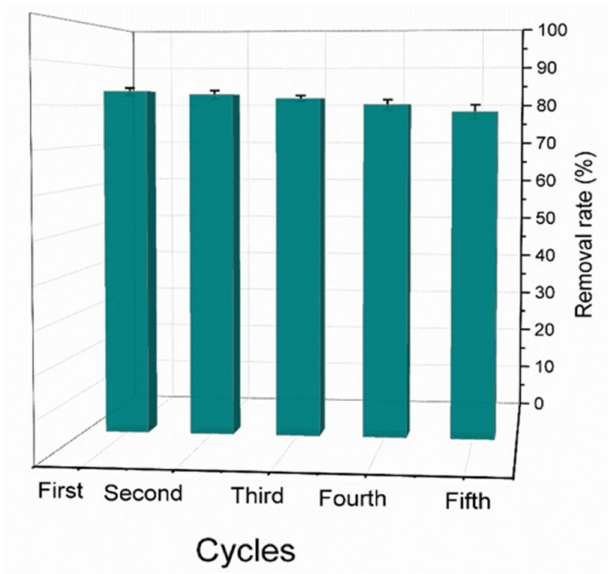
Figure 7. Recycling performance of photocatalytic degradation of MeB by BiOBr/Bi 2 S 3 /CdS com- posite under visible light